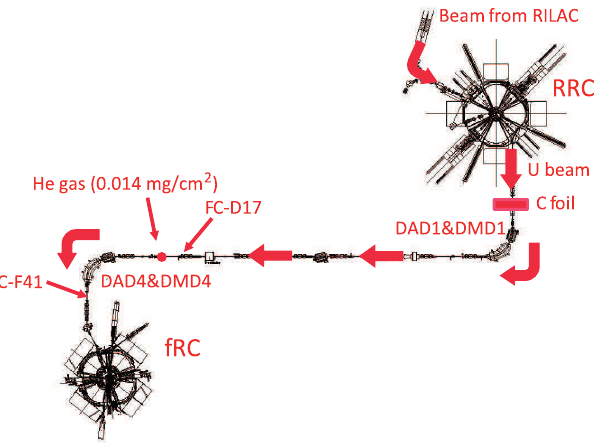
FIG. 4. Schematic of experimental setup for the measurements of cross sections of e-loss and e-capture for uranium beams at 11, 14, and 15 MeV = nucleon in RIBF beam lines between RRC and fRC. Uranium beams emerging from RRC passed through a carbon foil located in front of a pair of bending magnets (DAD1&DMD1), which were used to select the individual projectile charge state. After emerging from the He gas cell, the beams passed through the second bending magnet (DAD4&DMD4) into the Faraday cup at point F41 (FC-F41), which measured the intensity of the beam current of the charge state for e-loss, e-capture, no reaction, and so on. The Faraday cup at D17 (FC-D17) measured the current of the incoming ion with the aim of eliminating its